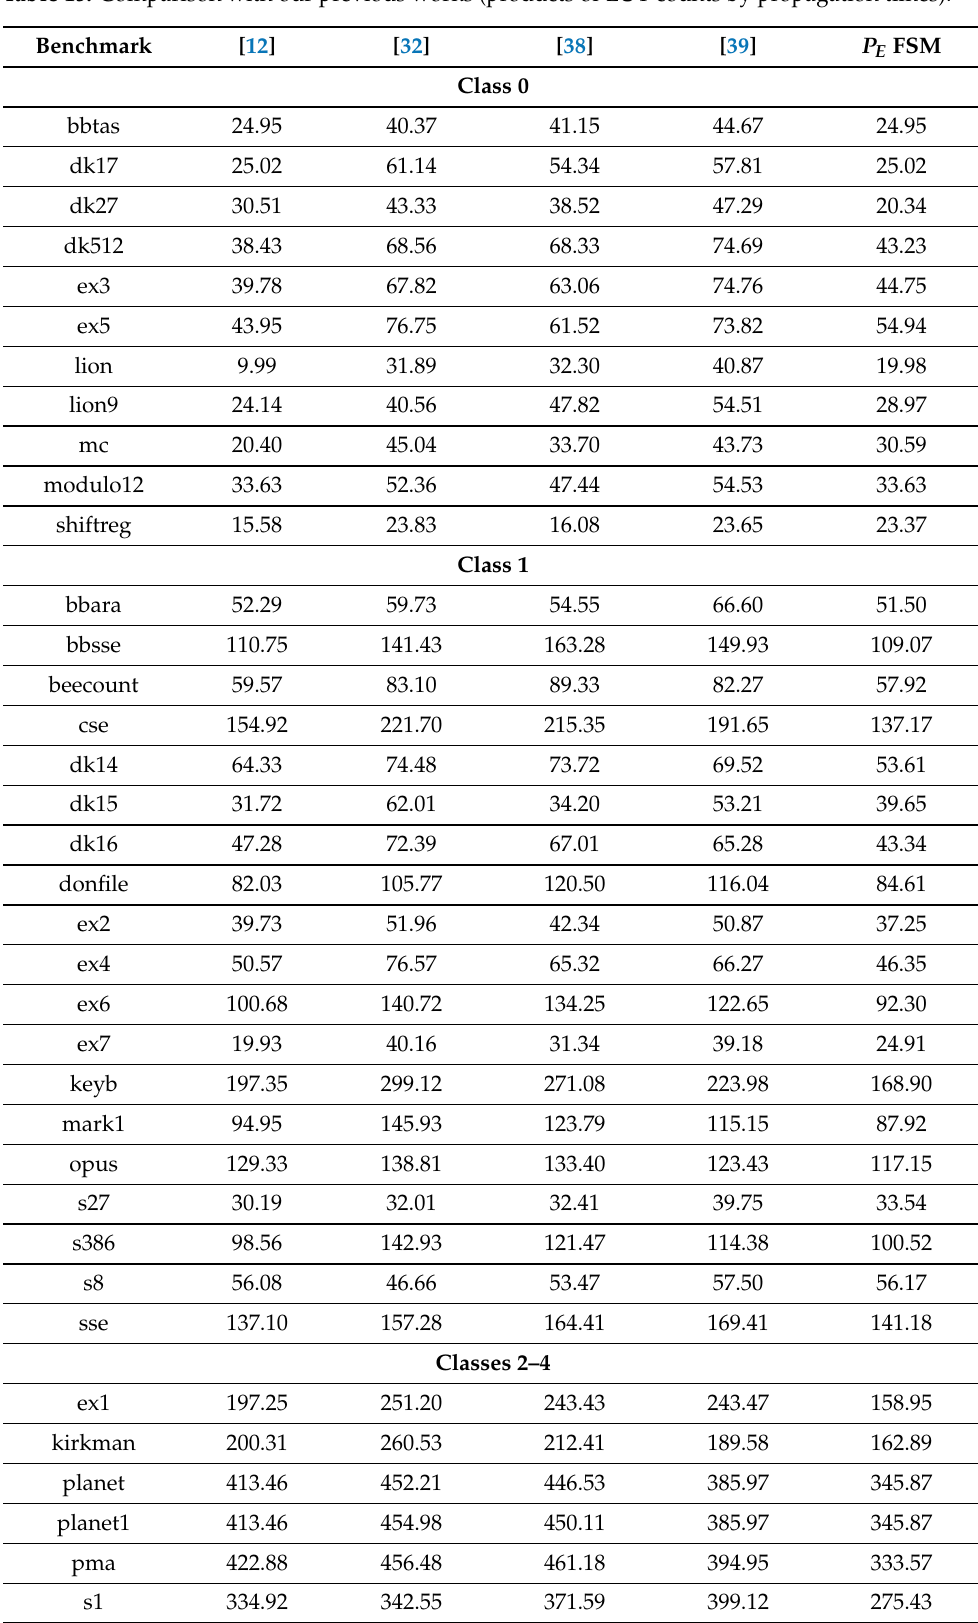
Table 15. Comparison with our previous works (products of LUT counts by propagation times).